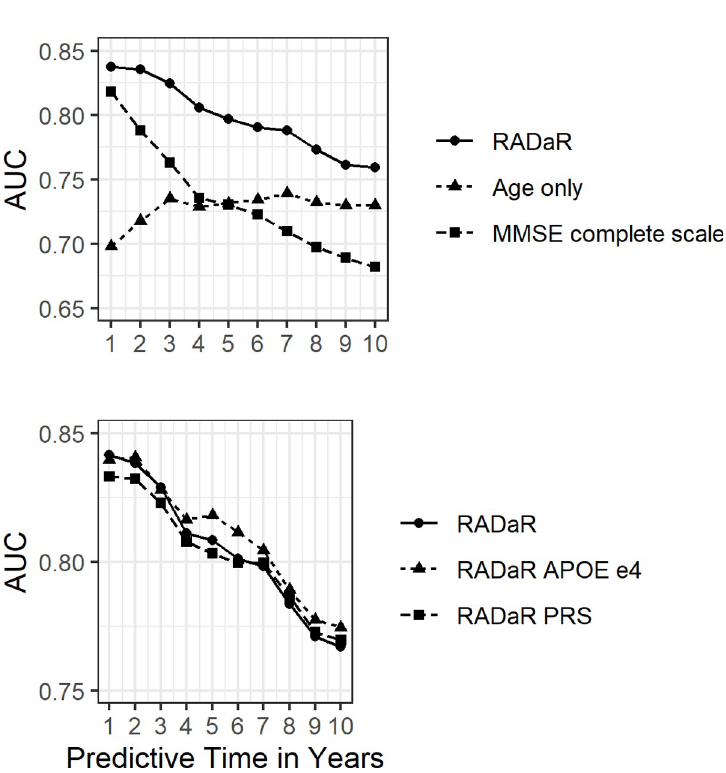
Fig 2. Comparison of AUC for predictive times from 1 to 10 years. RADaR versus age alone and MMSE for the total sample (top) and RADaR with and without genetic information for the sample with genetic information (bottom).